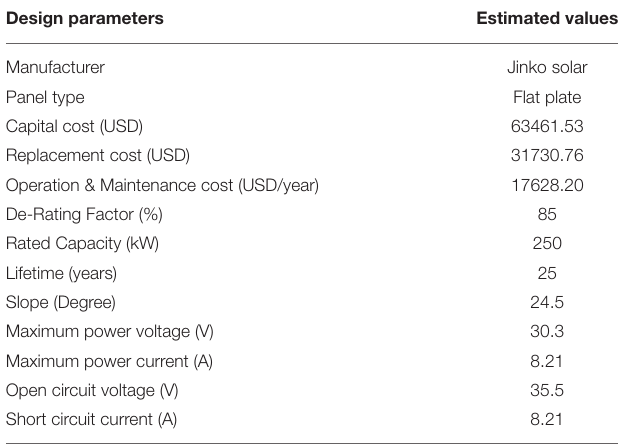
TABLE 3 | Solar system design parameters for hospital